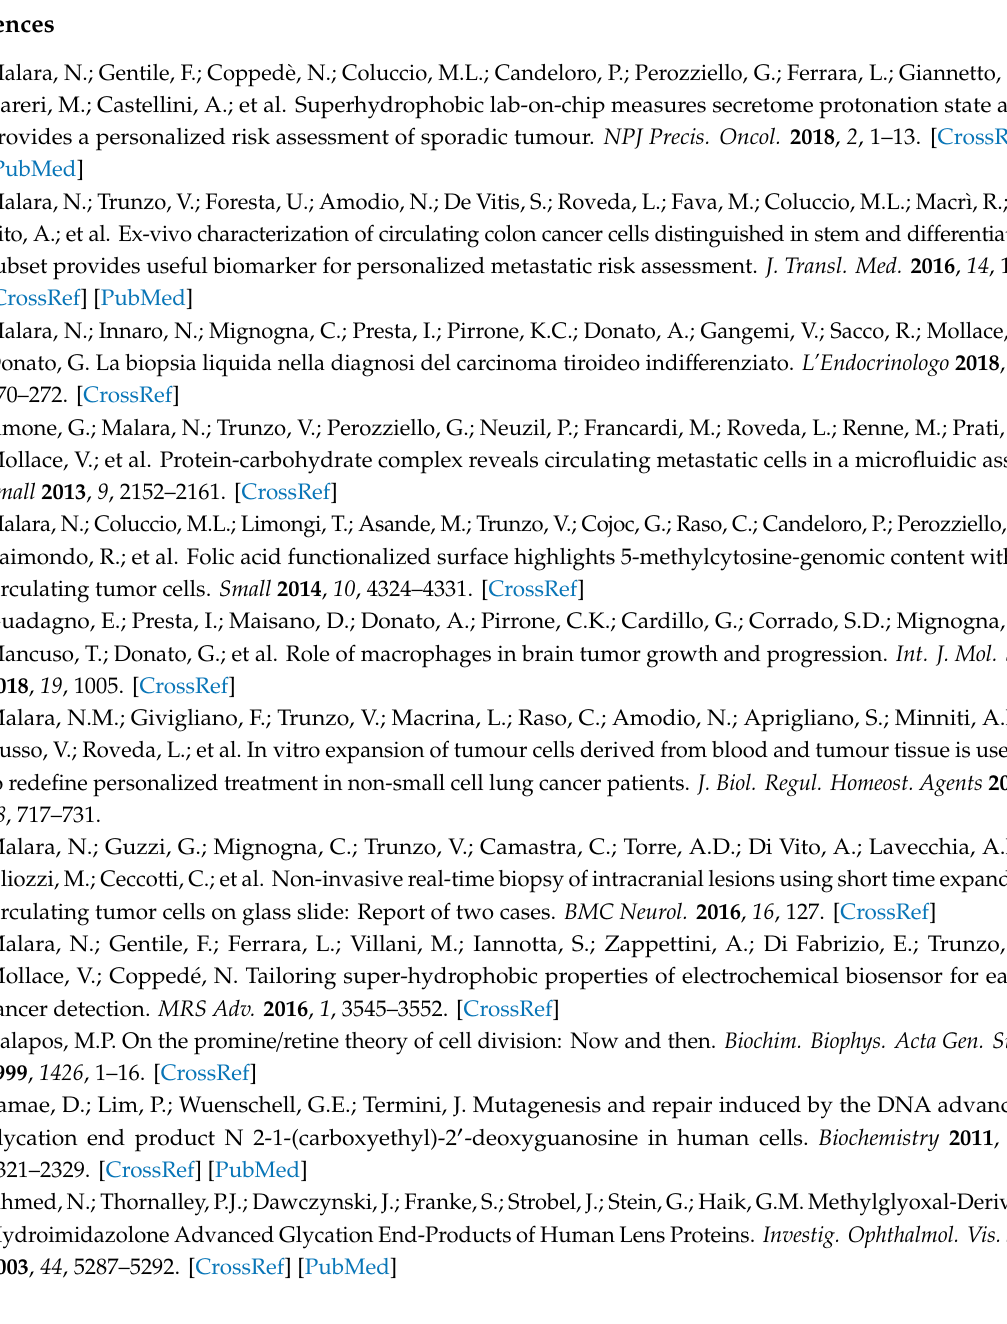
Supplementary Table S1 Excel file. Clinical and Experimental details of subjects